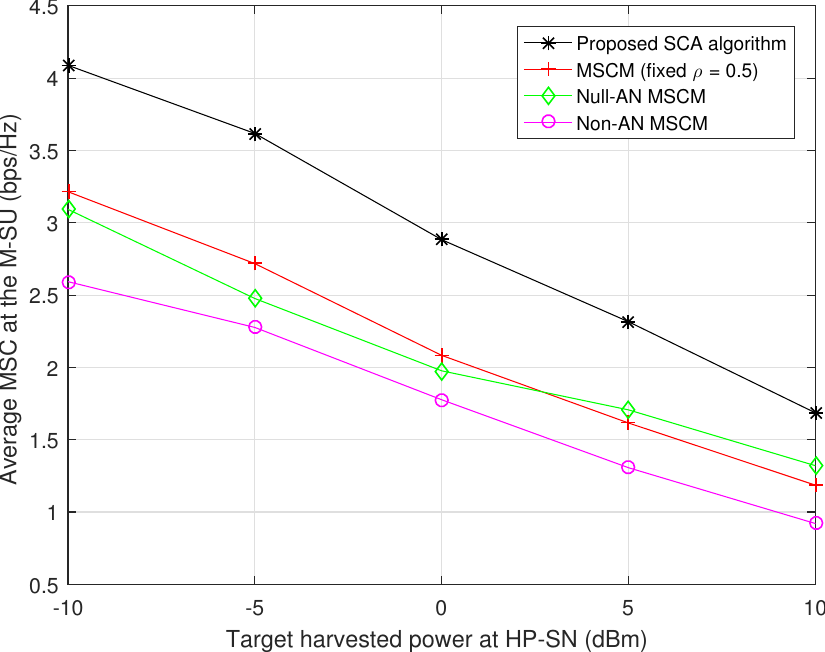
Figure 5. Average MSC at the M-SN with respect to the target harvested power at HP-SN.